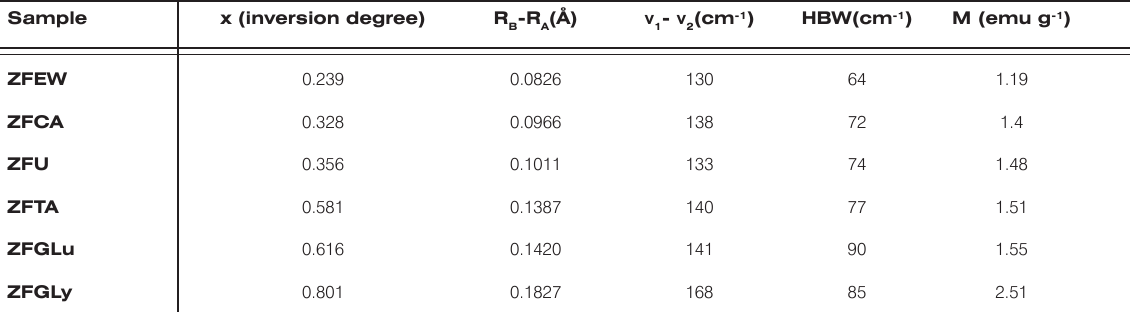
Table 6. Comparative trend between inversion degree value, FT-IR and VSM data.